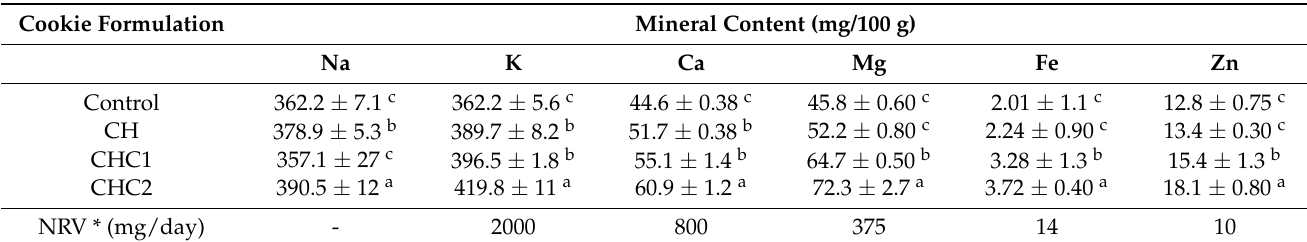
Table 3. Mineral content (mg/100 g) and nutritional reference value (NRV) of gluten-free